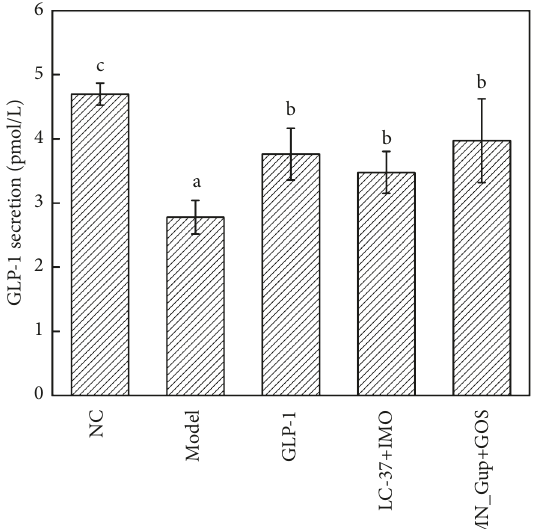
Figure 6: Effects of LC-37 and MN-Gup with prebiotics on serum GLP-1 levels. Data are shown as means ± standard deviations (SD), and different lowercase letters indicate significant differences, p < 0 . 05 ( n �